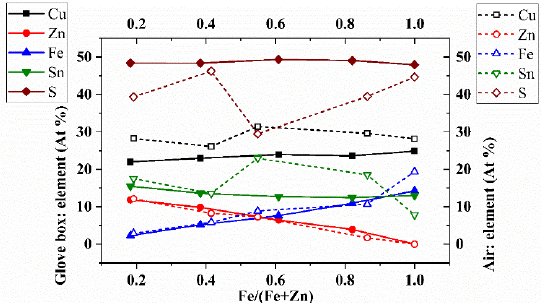
Figure 5. Atomic percentages of Cu, Zn, Fe, Sn, and S, calculated by energy-dispersive spectroscopy, EDS, measurements of the 20%, 40%, 60%, 80%, and 100% C(Z,F)TS thin films, made in glovebox and air, versus the Fe/(Fe+Zn) ratio.